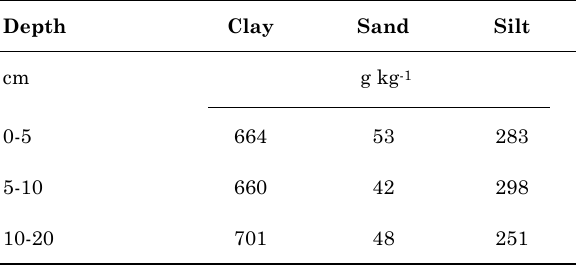
Table 2. Particle size composition in the 0-5, 0-10, and 10-20 cm layers of a latossolo Vermelho distroférrico (Typic Hapludox) used for setting up the field experiment